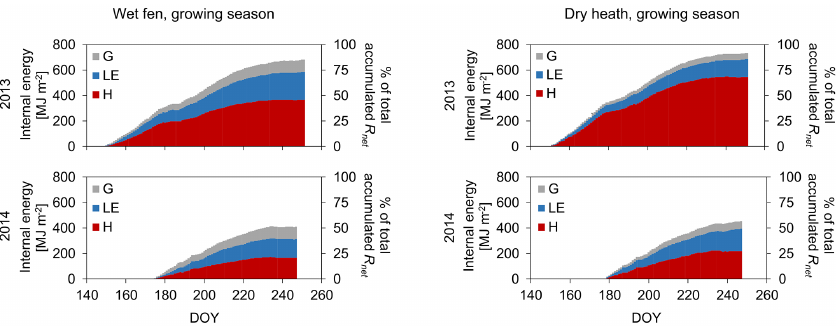
Figure 7. Development of internal energy. Accumulated ground heat ( G ), latent heat (LE) and sensible heat ( H ) at the wet fen (left panels) and the dry heath (right panels) during the growing seasons in 2013 and 2014.